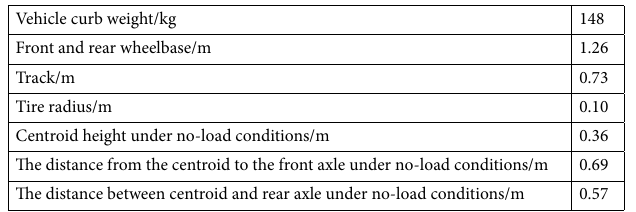
Table 3. Parameters of the distributed drive AGV.